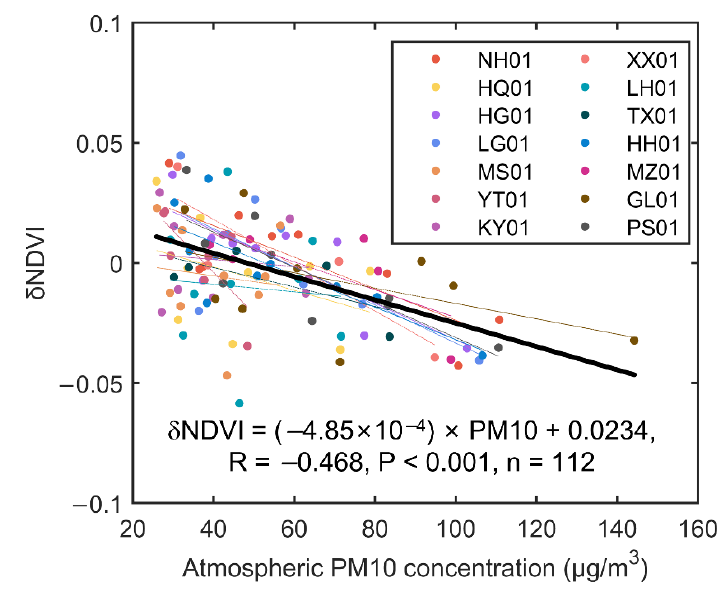
Figure 4. Correlation between atmospheric PM10 concentration and the relative change in the normalized difference vegetation index ( δ NDVI) at all stations over the study period. Each color represents a dataset for a station. Each point represents one data pair in one period, and each line represents the fitting curve of one station during the entire period (black line, R = − 0.468, n = 112, p < 0.001). The thick black line represents the fitting line for all 112 data. See Figure S1 for individual fitting of each station.